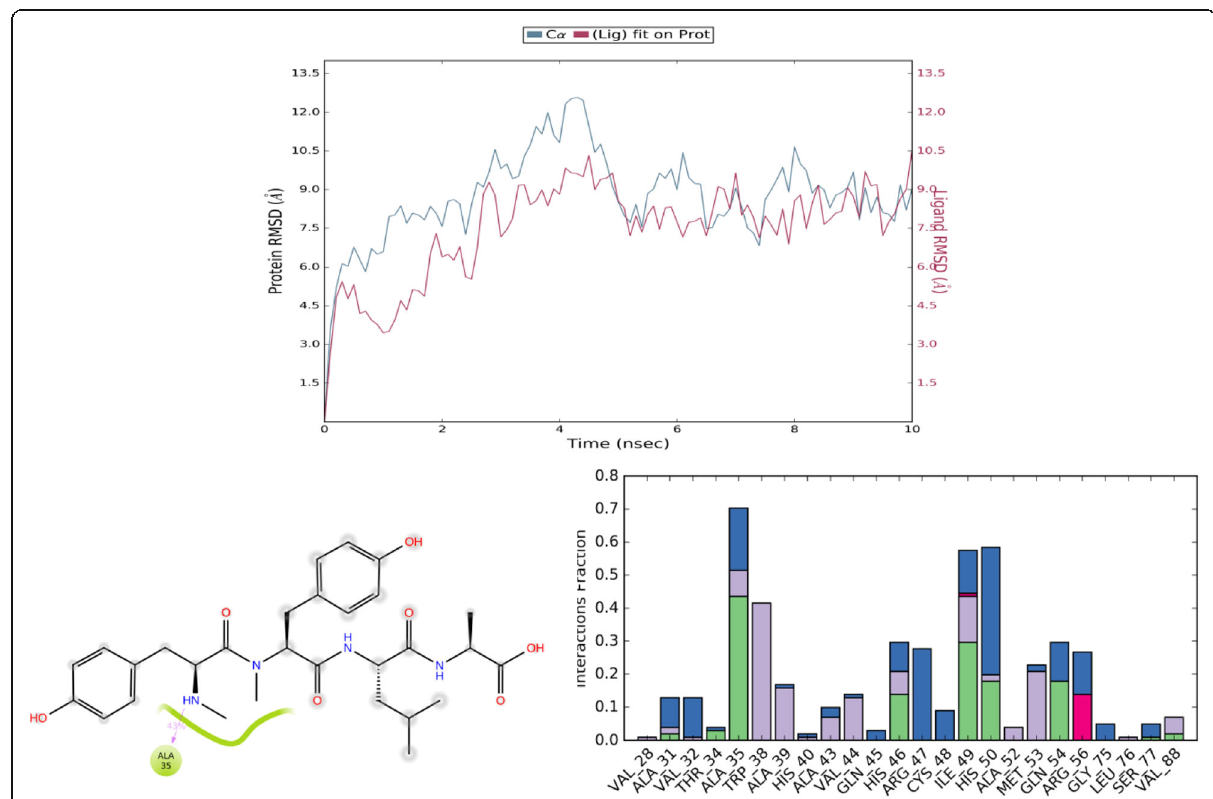
Fig. 7 RMSD plot and protein-ligand contacts for GP63-N-methyltyrosyl-N-methyltyrosyl-leucyl-alanine complex (UNPD86509)